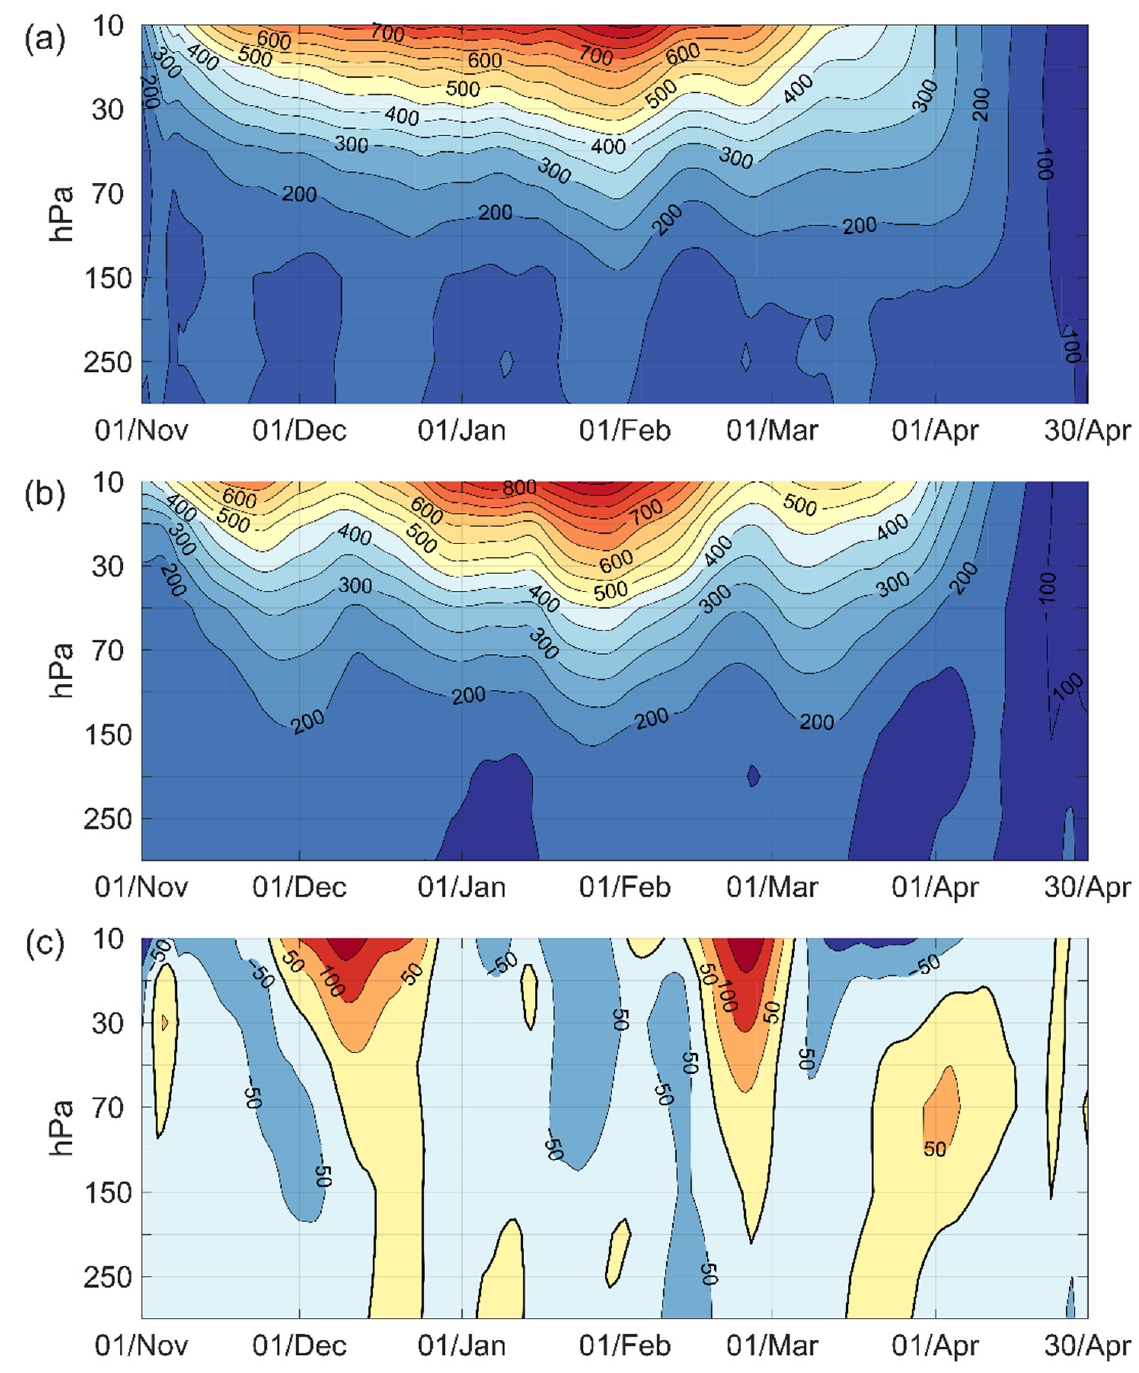
Figure 4. Composite vertical sections of amplitude of wave with zonal wave number 1 averaged between 50 and 70° N for ( a ) Eastern Pacific and ( b ) Central Pacific El Niño events and ( c ) difference between composites of EP and CP El Niño events. Values are smoothed with a 15-day running mean. Contour interval is 50 gpm. Black bold line indicates zero isoline.